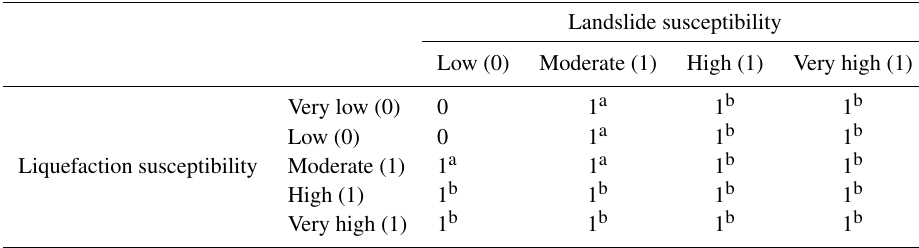
Table 3. Landslide and liquefaction susceptibility for network disruption in ABMS.